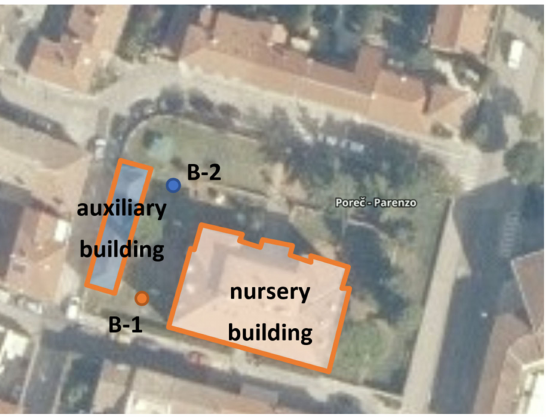
Figure 5. The positions of buildings and wells (B-1 supply well, B-2 return